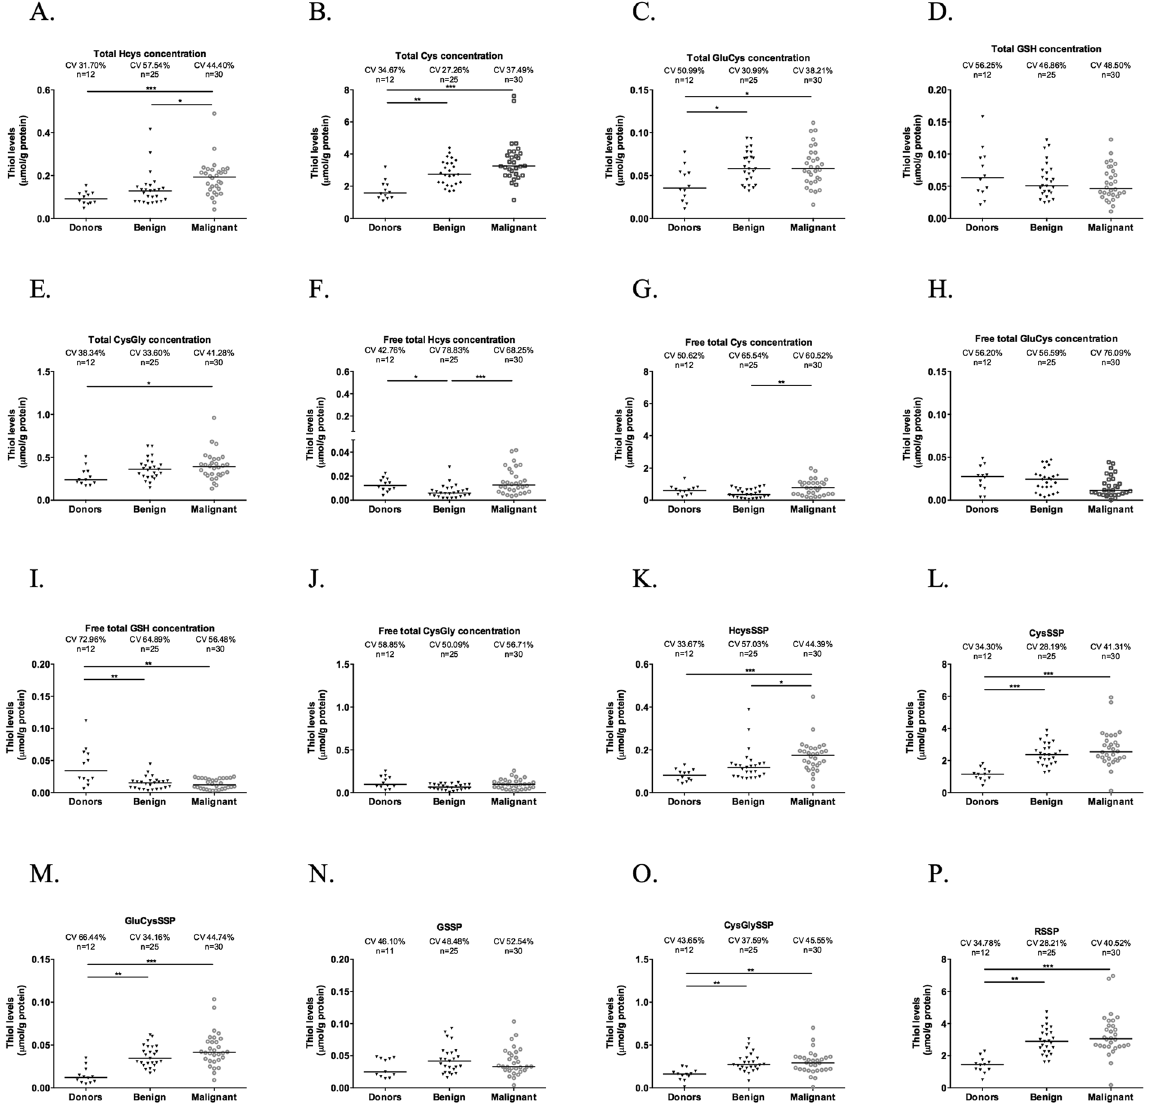
Figure 7. All thiols but GSH are increased in patients with ovarian tumours- high GSH turnover. Total thiols quantification in serum from healthy individuals (donors) and in serum from patients with benign and malignant ovarian tumours for ( A ) HCys- Homocysteine, ( B ) Cys – cysteine, ( C ) GluCys – Glutamylcysteine, ( D ) GSH – Glutathione, ( E ) CysGly – Cysteinylglycine. Thiol concentration was normalized by protein concentration. Free total thiols quantification in serum from healthy individuals (donors) and in serum from patients with benign and malignant ovarian tumours for ( F ) HCys- Homocysteine, ( G ) Cys – cysteine, ( H ) GluCys – Glutamylcysteine, ( I ) GSH – Glutathione, ( J ) CysGly – Cysteinylglycine. Thiol concentration was normalized by protein concentration. Thiols concentration bound to proteins quantification in serum from healthy individuals (donors) and in serum from patients with benign and malignant ovarian tumours for ( K ) HcySSP – S - homocysteinylated proteins, ( L ) CysSSP – S - cysteinylated proteins, ( M ) GluCysSSPS – S - Glutamylcysteinylated proteins, ( N ) GSSP – S - glutathionylated proteins, ( O ) CysGlySSP – S - cysteinylglycinylated proteins. ( P ) RSSP – total S - thiolated proteins. Thiol concentration was normalized by protein concentration. Results are shown as median. The * represent the statistical significance among groups. * p < 0.05, ** p < 0.01, *** p < 0.001 (independent samples Kruskal Wallis One-way ANOVA with multiple